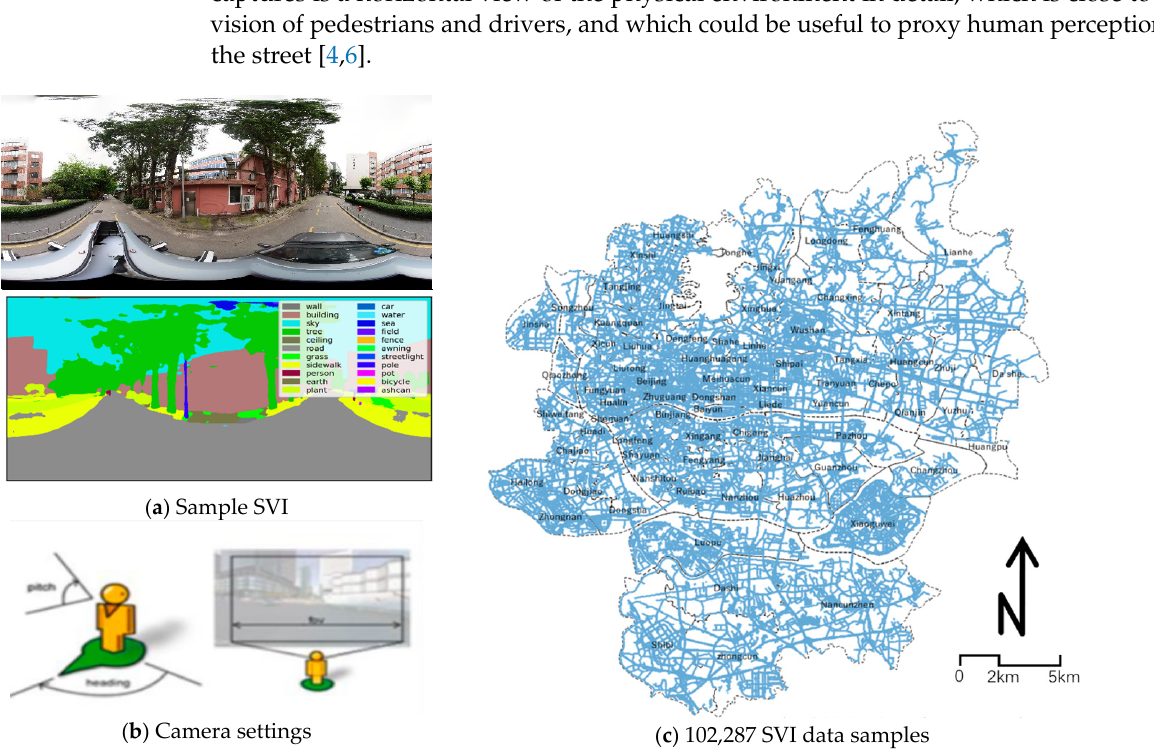
(Figure 4b). What Baidu SVI captures is a horizontal view of the physical environment in